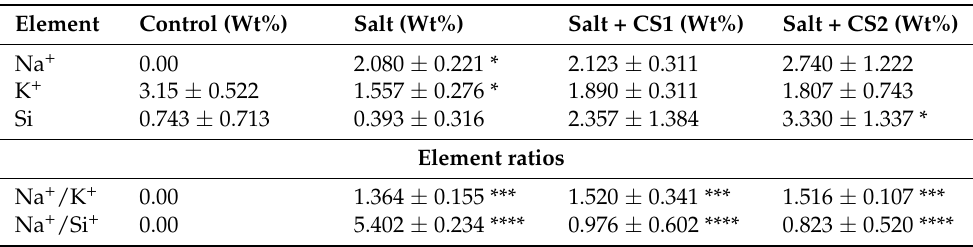
Figure 3. The effects of chitosan on the element distribution and formation of silica phytoliths on sorghum shoots under control and salt conditions. ( A – D ) SEM-EDX spectra showing the content of different ions, ( E – H ) SEM micrographs showing the sorghum surface for mapped ions, (the mapped area is shown by a green box). Silica cells and phytoliths are shown using blue and red arrows, respectively. ( A , E ) (0 mM NaCl); ( B , F ) (salt, 300 mM NaCl), ( C , G ) (salt + 0.25 mg/mL chitosan), ( D , H ) (salt + 0.5 mg/mL chitosan). Table 2. Effects of chitosan on element distribution in sorghum shoots of control and salt stress conditions. Data represented are mean ±